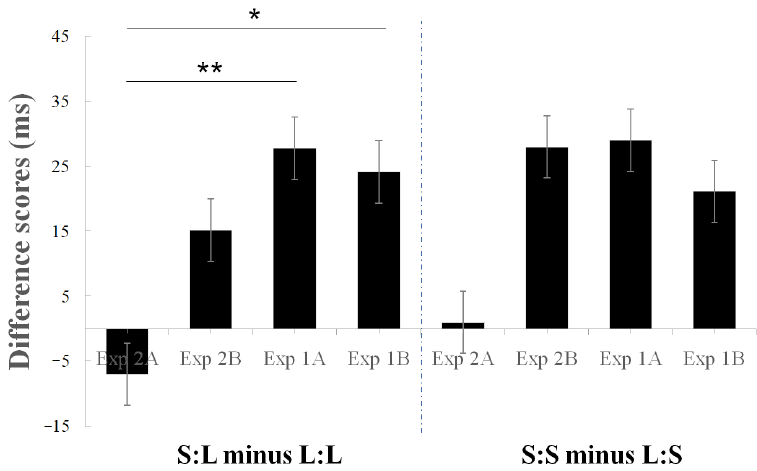
Figure 7. Difference scores in Experiment 1 and Experiment 2. The difference scores in S:L and L:L are significantly different between Experiment 2A (Exp2A) and Experiment 1A (Exp1A) and between Exp2A and Experiment 1B. * p < 0.05, ** p <